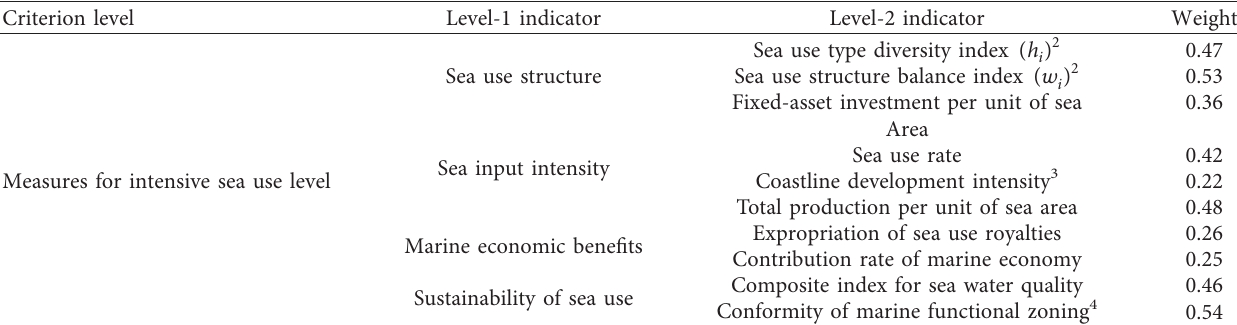
Table 2: Comprehensive evaluation indicator system for intensive sea